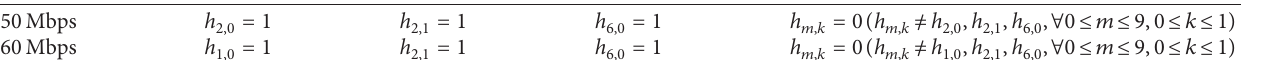
Figure 5: Global comparison for each algorithm when S � 2. Table 4: Network configurations of HO algorithm in 50Mbps and 60Mbps when S � 2.